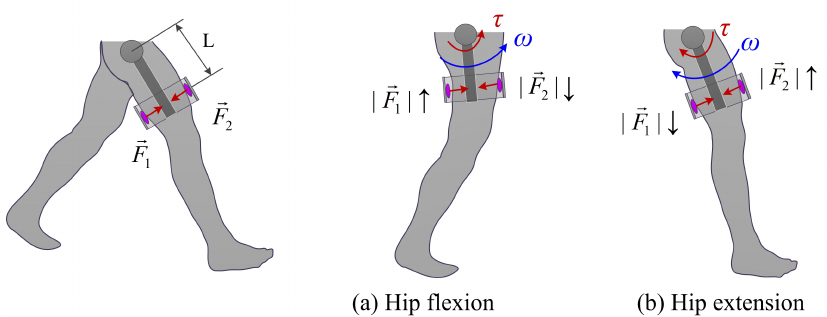
Figure 11. Schematic diagram of human-exoskeleton interaction force/torque measurement. The directions of the interaction forces are defined in the figure.